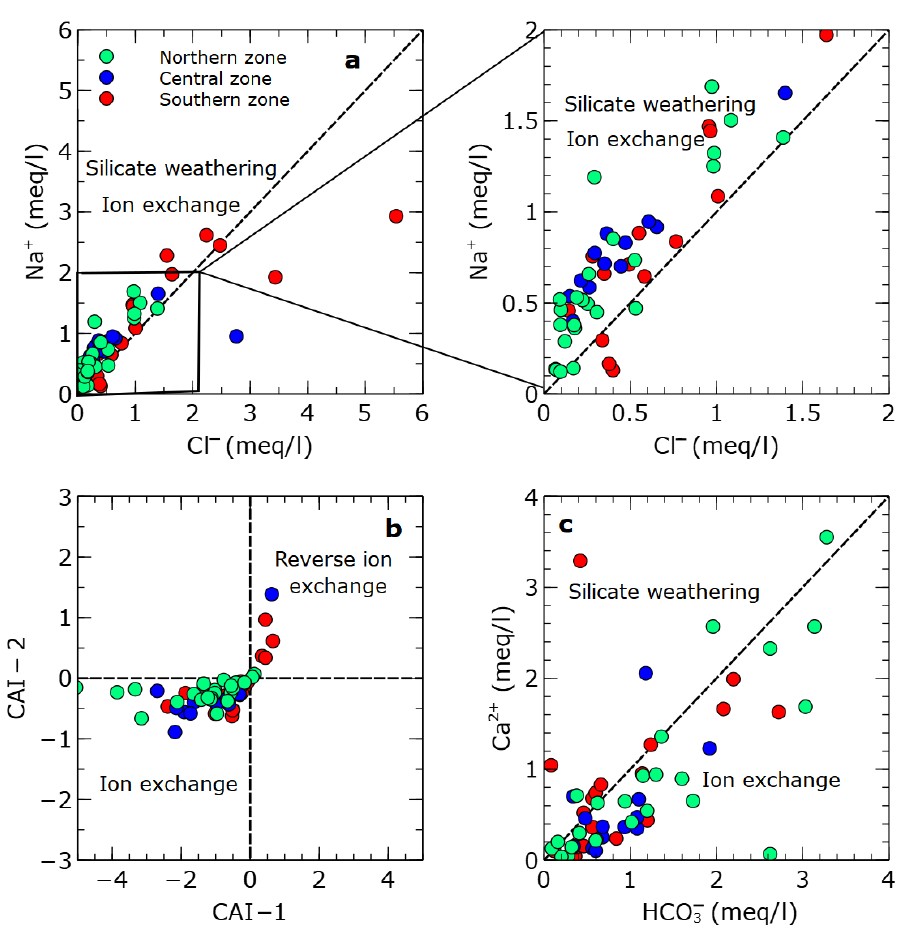
Figure 12. Bi-variate ion plots showing the most probable geochemical processes, including silicate weathering ( a ), and ion exchange ( b , c ) in the groundwater